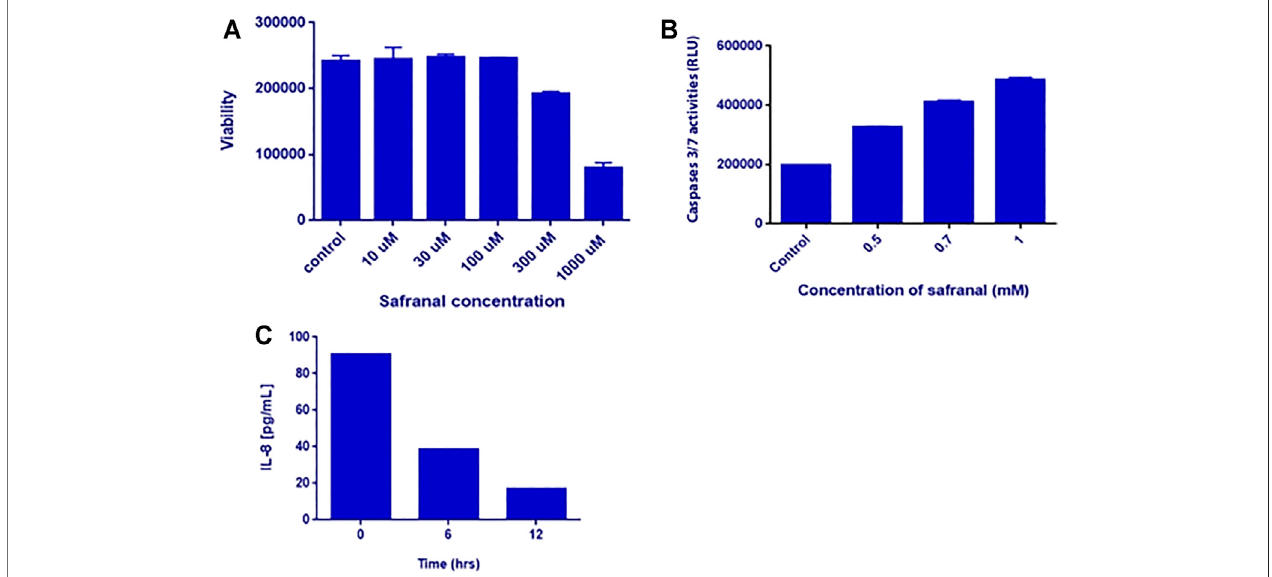
FIGURE 6 | In vitro analysis. (A) Viability of HepG2 cells after safranal treatment for 24 h. HepG2 cells were treated with 0.01, 0.03, 0.1, 0.3, and 1 mM of safranal. (B) Caspase-3/7 activities after safranal treatment for 48 h. HepG2 cells were treated with 0.5, 0.7, and 1 mM of safranal. (C) IL-8 secretion after safranal treatment. HepG2 cells were treated with 2 mM for 6 and 12 h, and subsequently, the supernatants were analyzed by IL-8 ELISA.